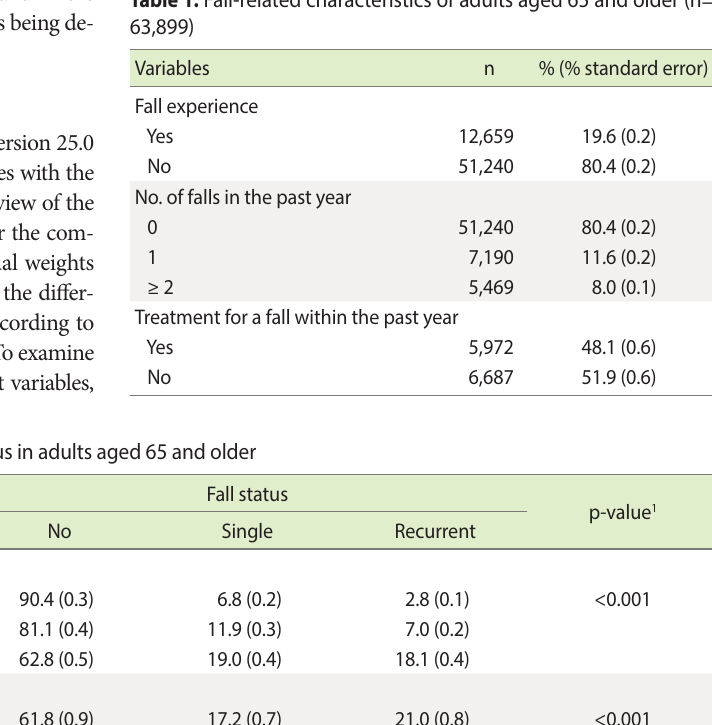
Table 1. Fall-related characteristics of adults aged 65 and older (n=